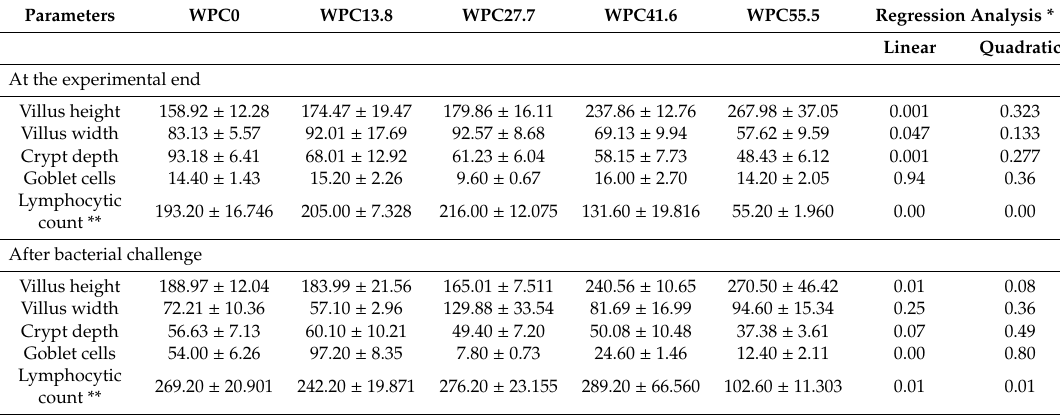
Table 5. The e ff ect of partial replacement of fish meal with whey protein concentrate on morphometric measures of the intestine ( µ m) of Nile tilapia fingerlings.